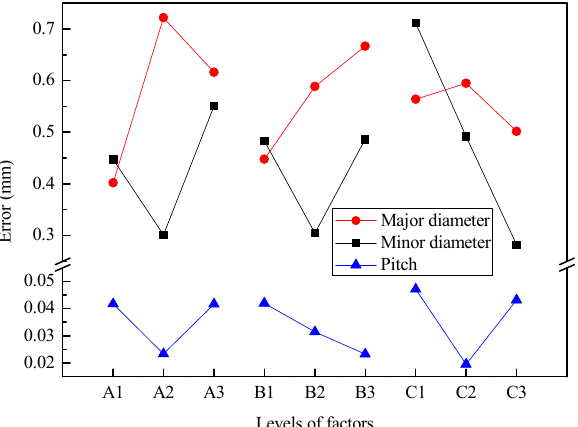
Figure 12. Effect of experimental factors on geometrical error for the threaded section. Figure 12. E ff ect of experimental factors on geometrical error for the threaded